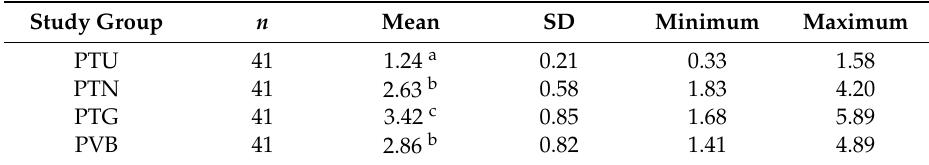
Table 1. Descriptive analysis of the time to failure